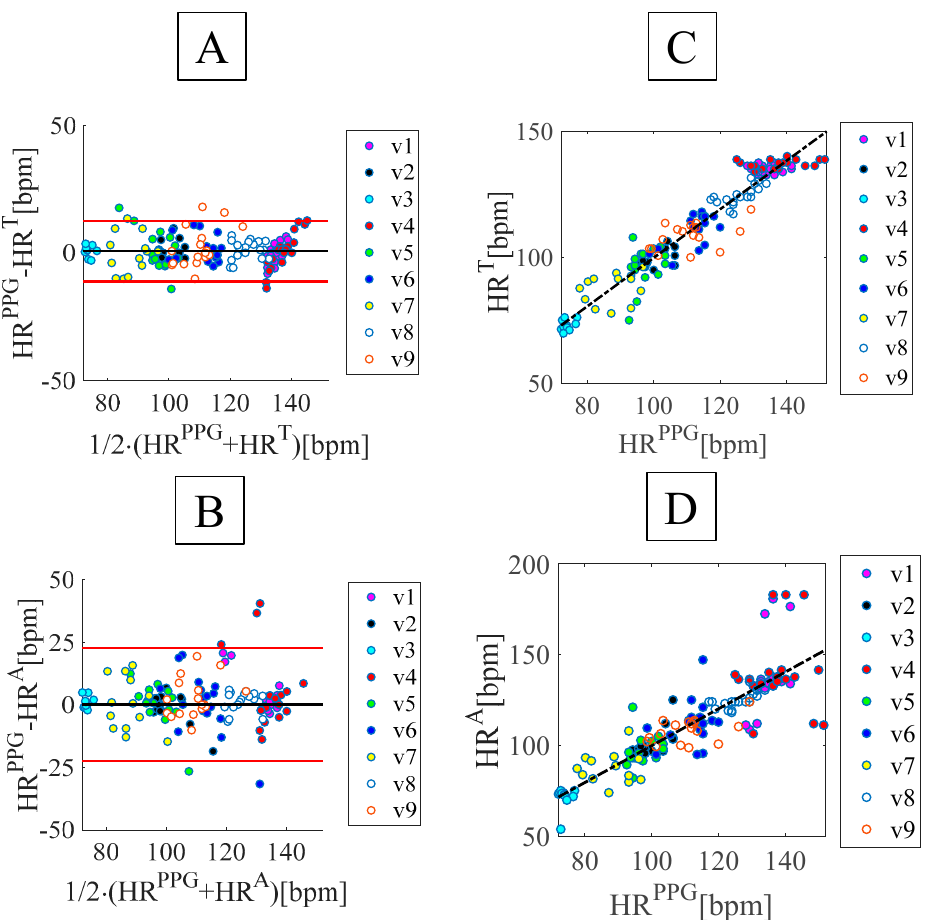
Figure 8. ( A ) and ( B ) Bland-Altman plots using FBG A and FBG T , ( C ) and ( D ) linear regression of the results obtained by FBG A and FBG T vs. the reference system. Table 3 . Bland-Altman of beat-by-beat analysis.